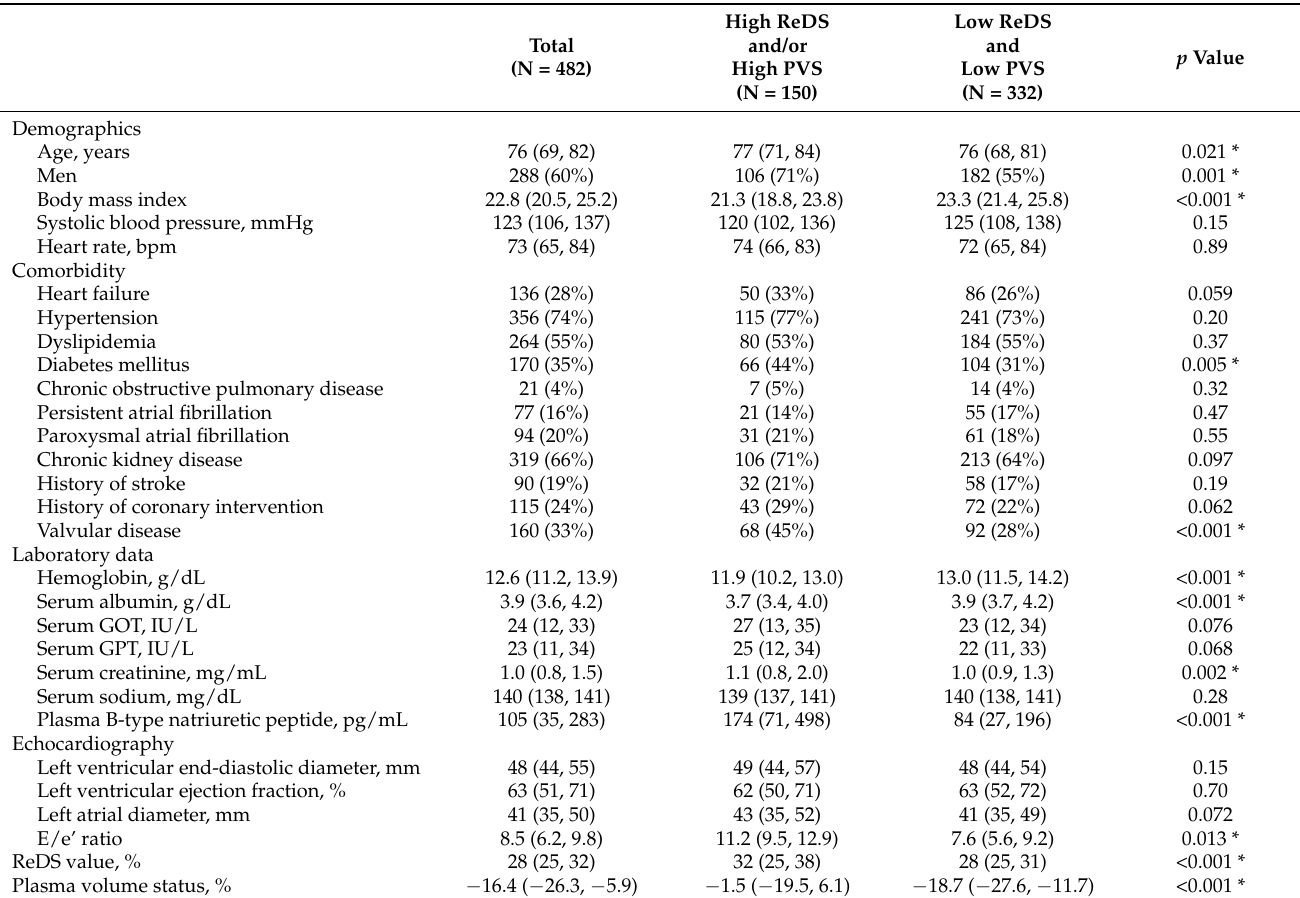
Table 1. Baseline